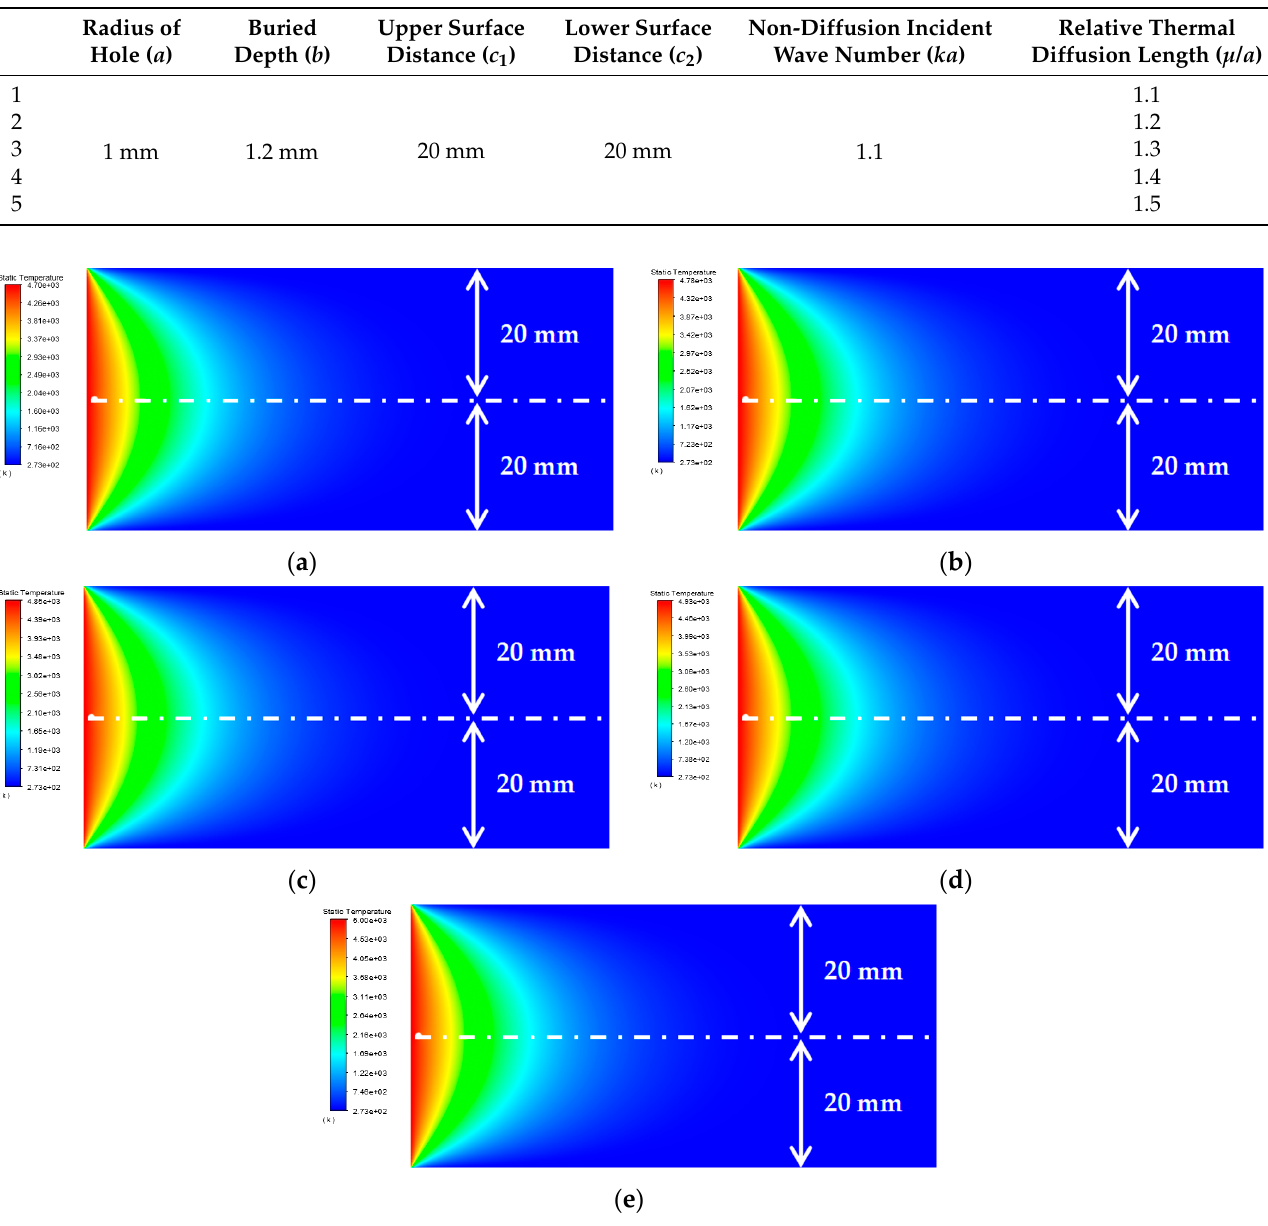
Table 6. Parameters of circular hole and incident light source in the fifth simulation.